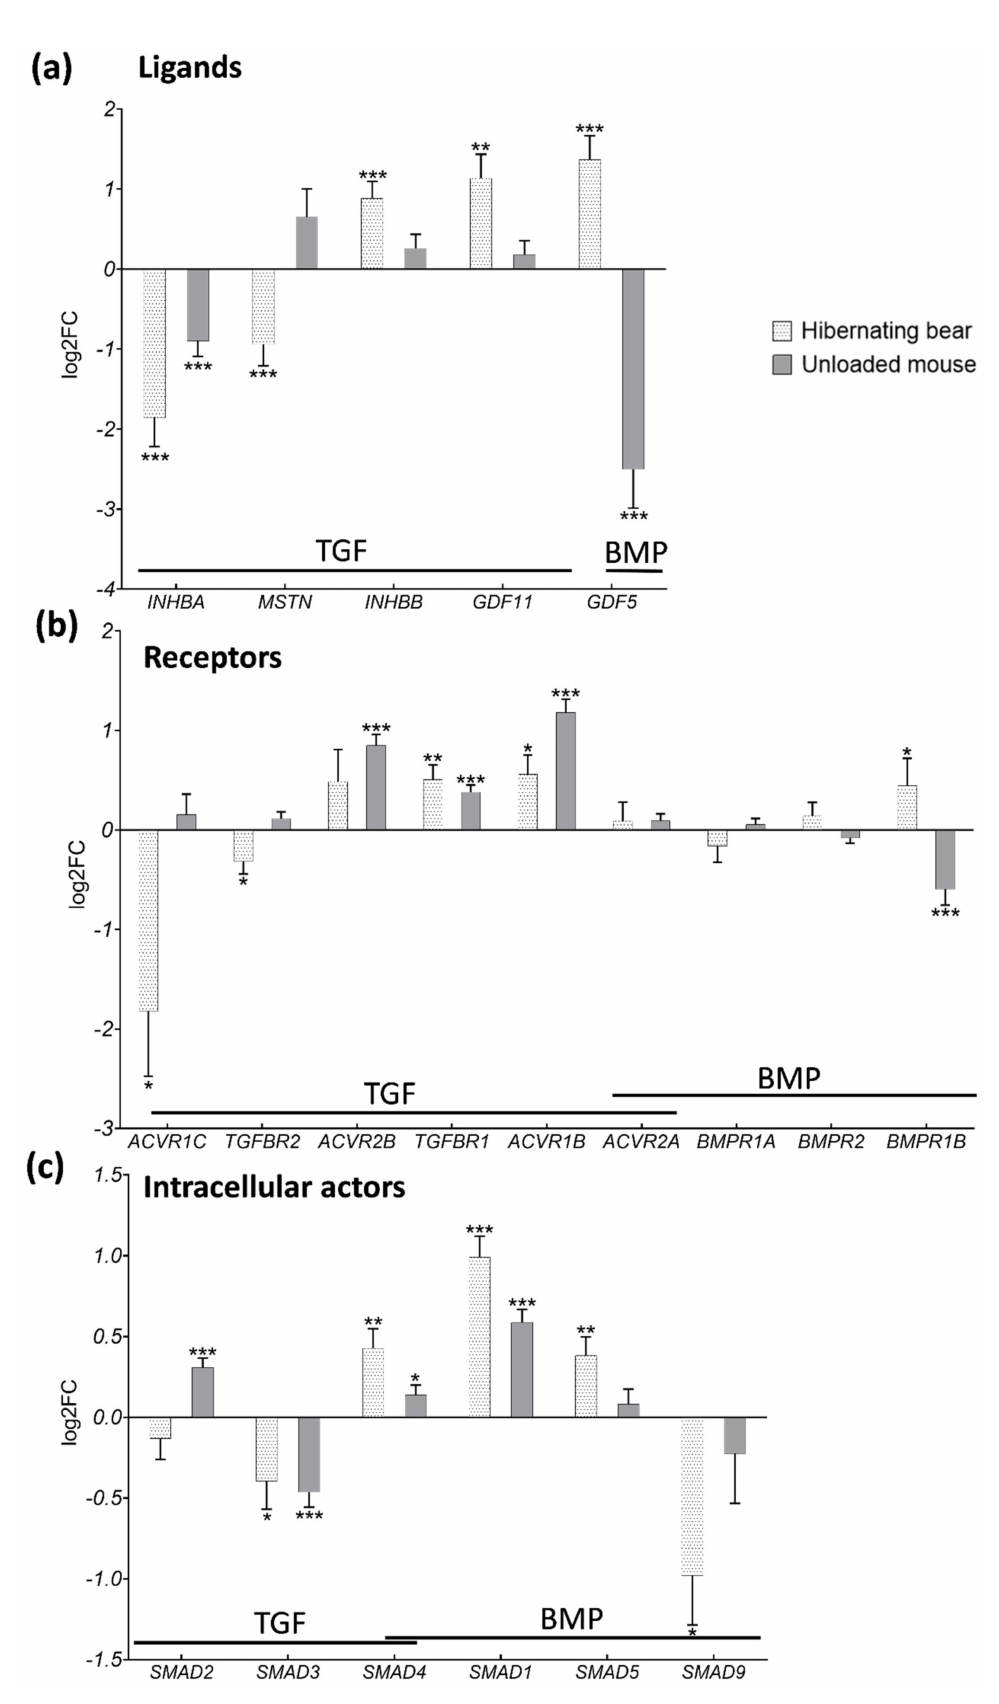
Figure 4. The gene expression pattern of TGF- β and BMP components is different in brown bear muscle resistant to atrophy during hibernation compared to atrophied muscles of the unloaded mouse. Genes expression level in vastus lateralis muscle